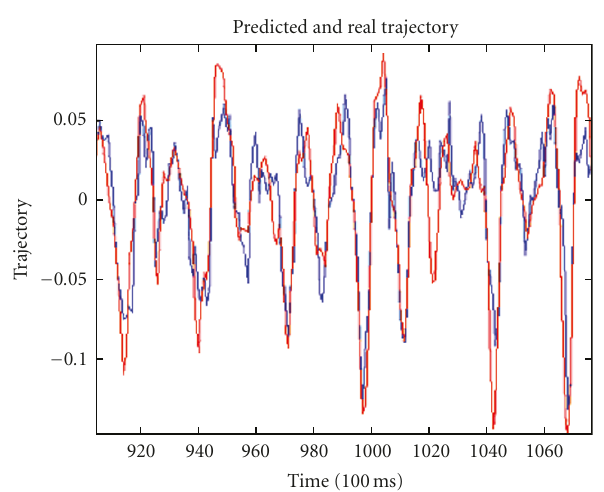
Figure 16: Reconstruction using unsupervised LM-HMM clusters (blue) versus Real Trajectory (red).